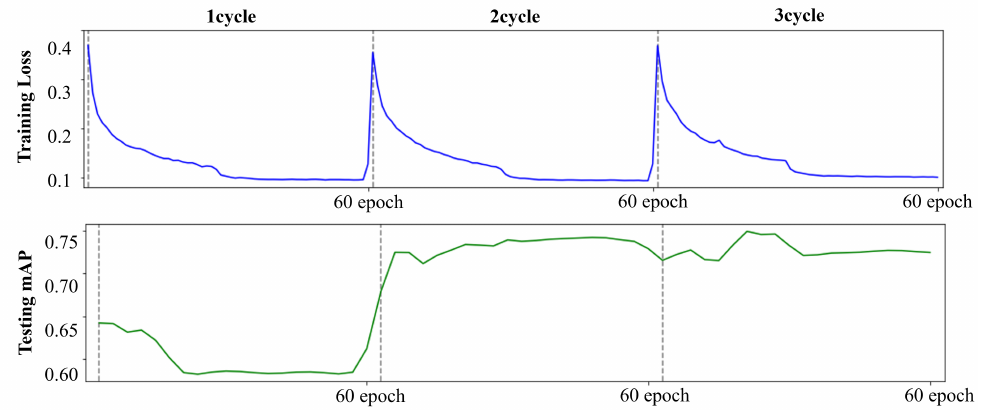
Figure 5. Training loss and mAP performance according to training progress. This graph depicts the progress of model training while the SC-Mix cycle is repeated. The top represents the change in loss value applied during the model training, while the lower represents the mAP performance on test data as measured every three epochs throughout the learning